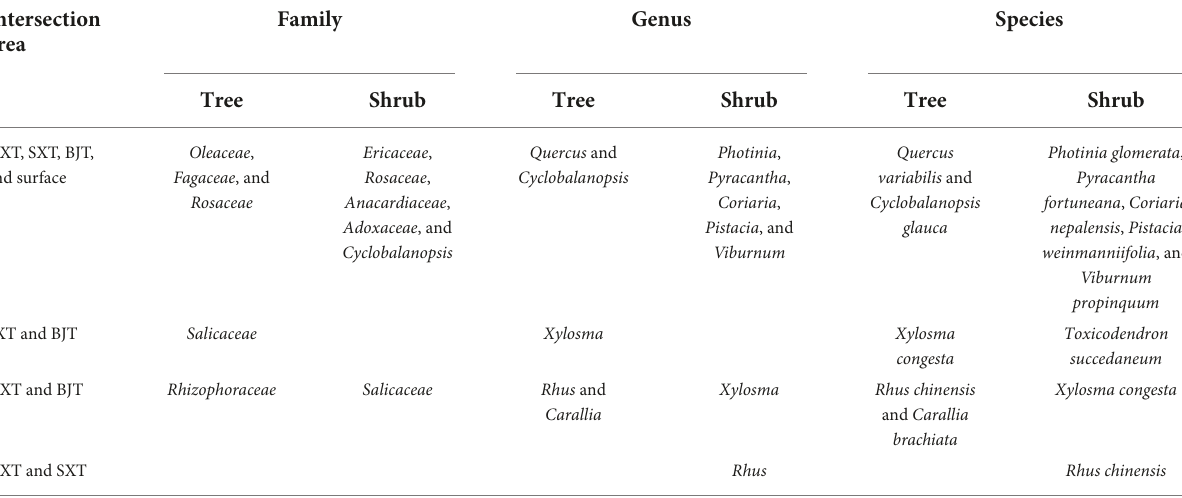
TABLE 3 Shared species within and outside the karst tiankeng groups. SJXT, SXT, BJT, and Surface indicates shared species in four habitats, SXT and BJT; SJXT and BJT; and SJXT and SXT means shared species in two habitats. Intersection